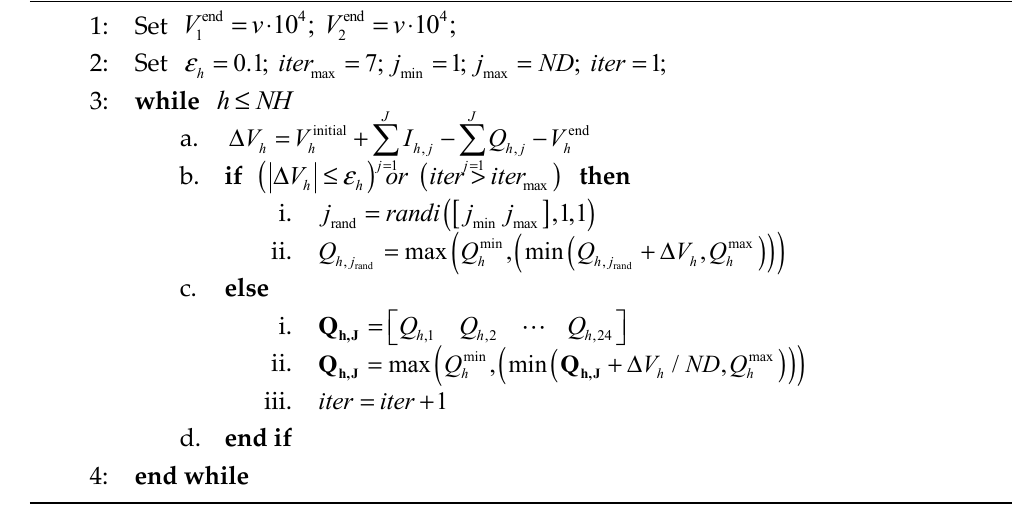
Algorithm 2: New constraints handling for constraints handling for water